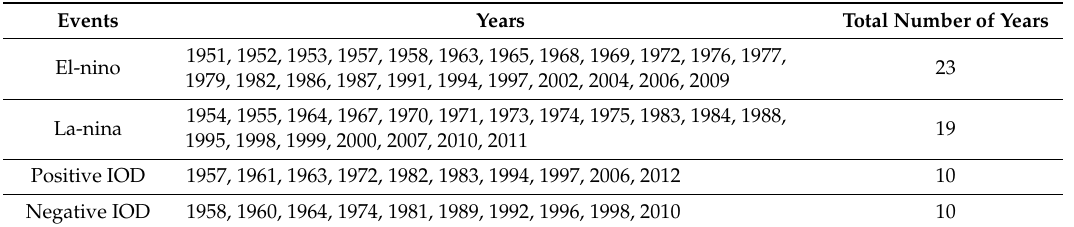
Table 3. List of the years considered for large-scale phenomena (like El Niño, La Niña, positive, and negative IOD) years. The analyses are carried out for the period 1951–2013.